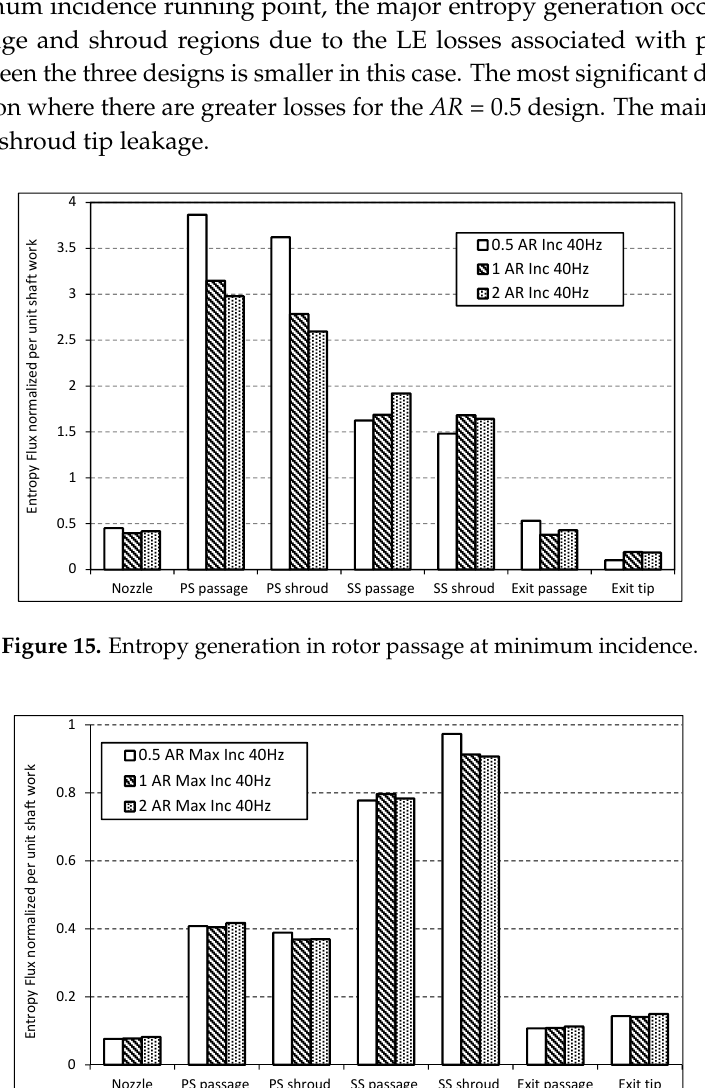
Figure 16. Entropy generation in rotor passage at maximum incidence.